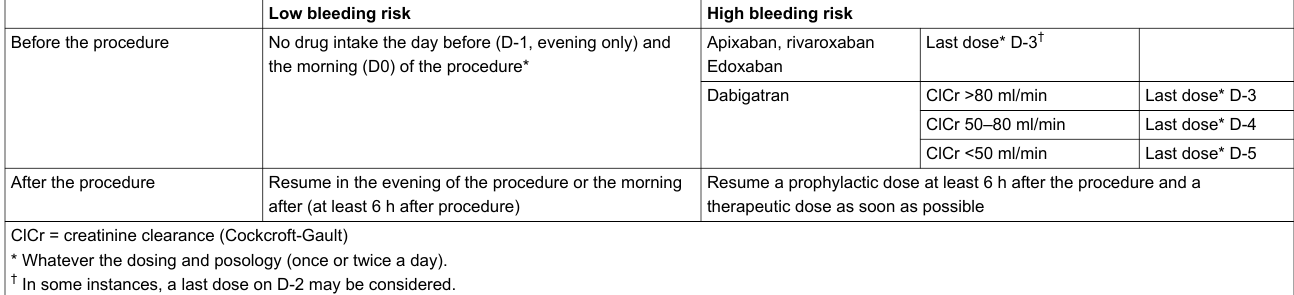
Table 5: Perioperative management with direct oral anticoagulants according to bleeding risk and renal function. Low bleeding